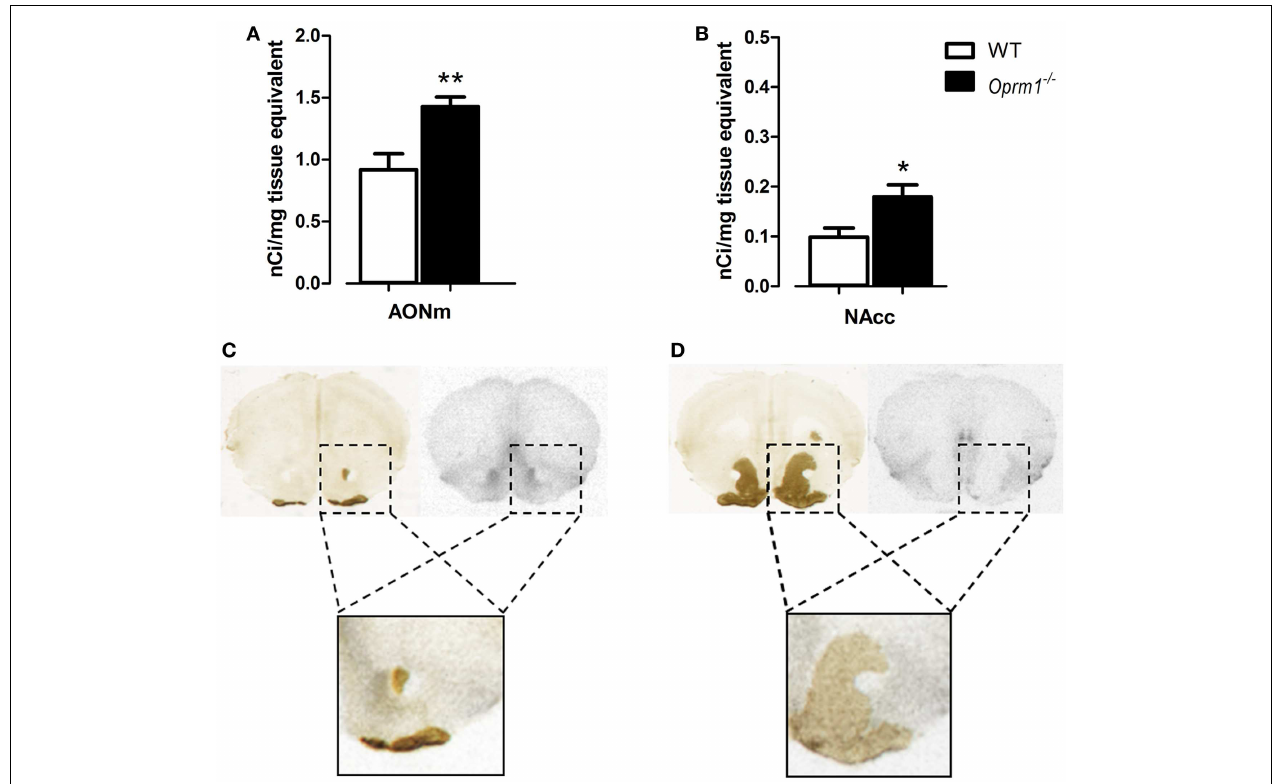
[ 125 I]-OVTA labeling evident in the autoradiographic picture and the AChE staining, apparently in the same position, do not overlap when the two images are merged (blow-up), indicating that the NAcc doesn’t express high levels of OXTR in this area. (D) Superimposition of the autoradiogram and the AChE staining of a coronal section of the NAcc where the AONm is not present anymore (blow-up) confirms that this region does not express high levels of